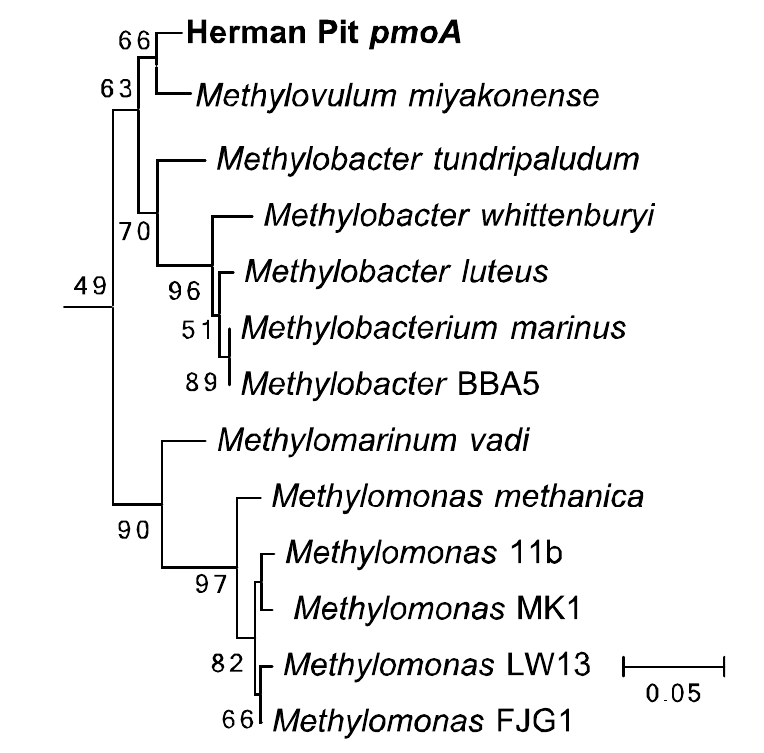
Figure 4. Neighbor-joining tree of the derived amino acid sequence of the pmoA gene amplified from the Herman Pit enrichment